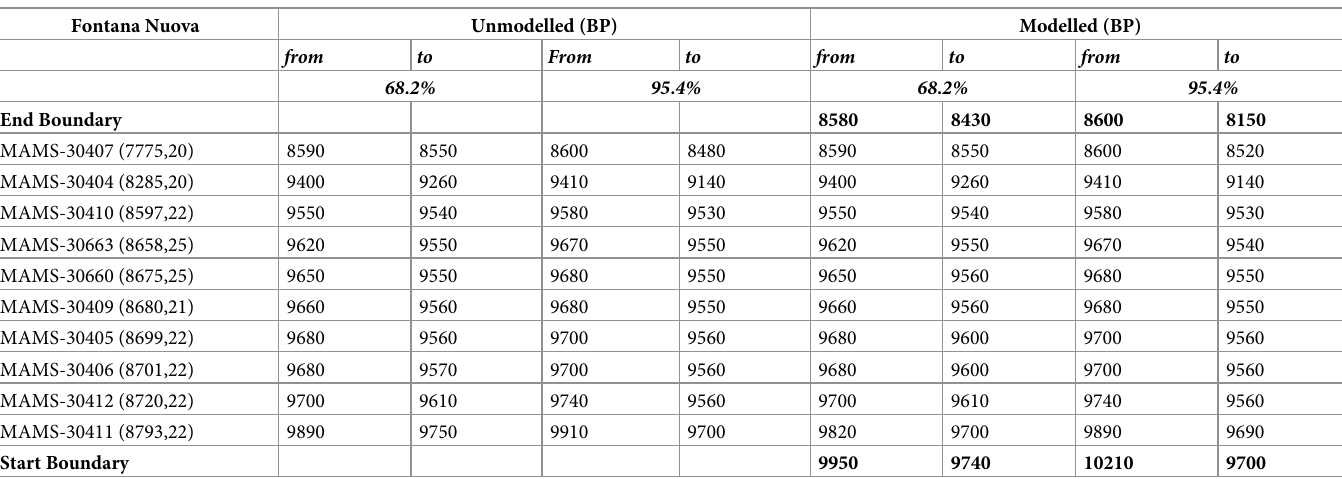
Table 2. Modelled radiocarbon dates.